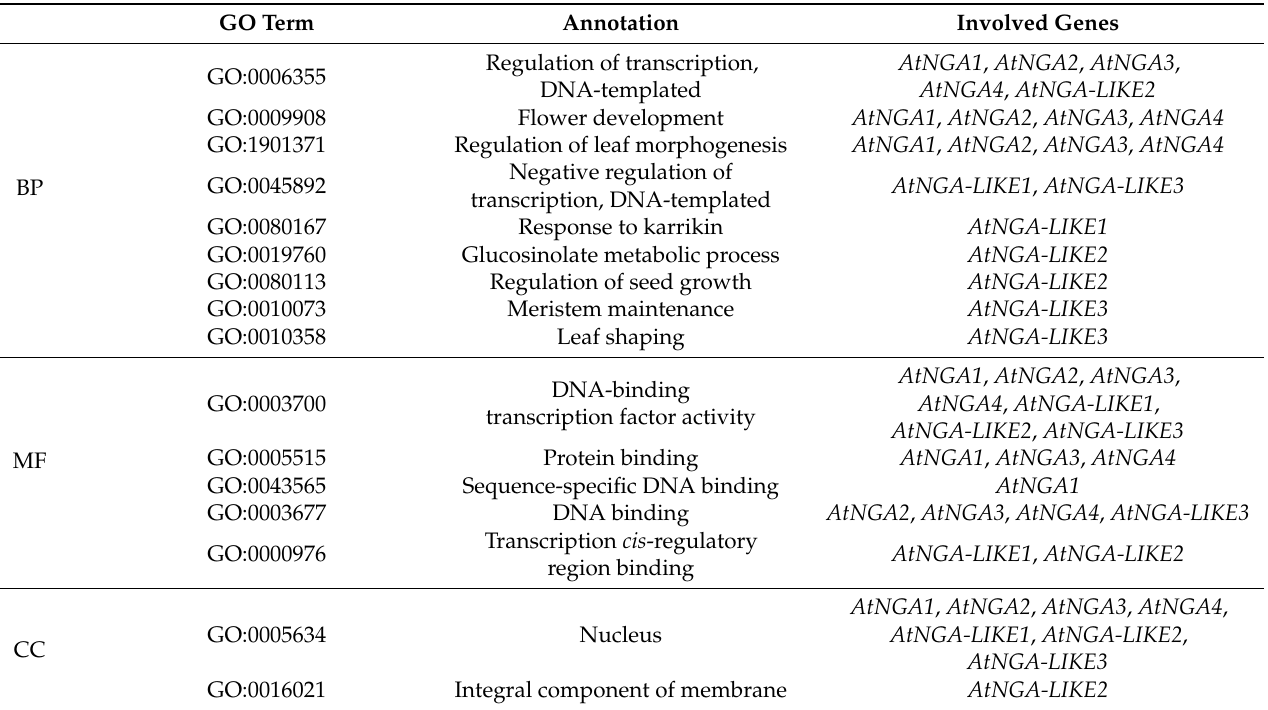
Figure 6. The GO annotation and classification of NGATHA proteins using Blast2GO. Results are summarized for the three main GO categories (BP, MF, and CC). The X-axis includes the most abundant GO terms. The Y-axis represents the number of NGATHA proteins. Table 5. The GO classification of the annotated NGATHA genes in Arabidopsis and tomato.